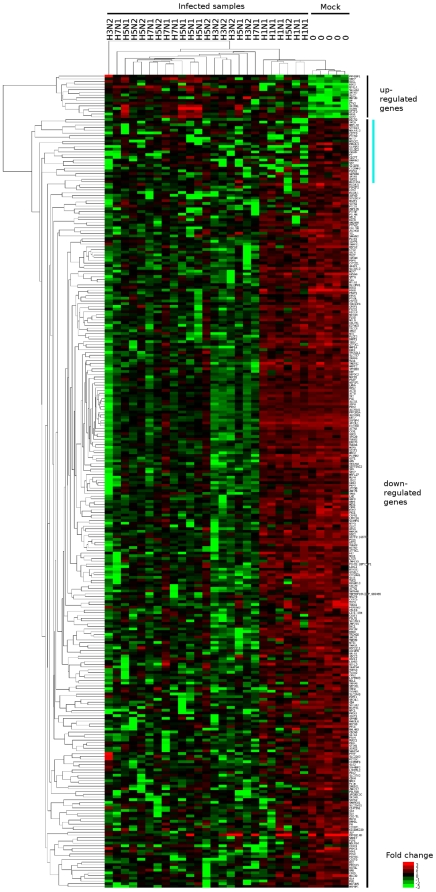
Hierarchical clustering and heatmap of the 300 genes that discriminate mock and infected samples.Heatmap representing the expression levels of the 300 genes differentially expressed between infected and mock cells. Red squares indicate the expression levels above the median of the gene abundance across the sample and green squares the expression levels below. The median values were clustered hierarchically in both dimensions. Dendograms indicate the correlation between groups of samples (horizontal) and genes (vertical). Vertical lines in the right portion indicate the 2 distinct gene expression patterns: up and down-regulated genes during infection. The blue line stands for the genes down-regulated in samples infected with H1N1 influenza virus. Gene expression data for the 300 genes are reproduced in table S2.